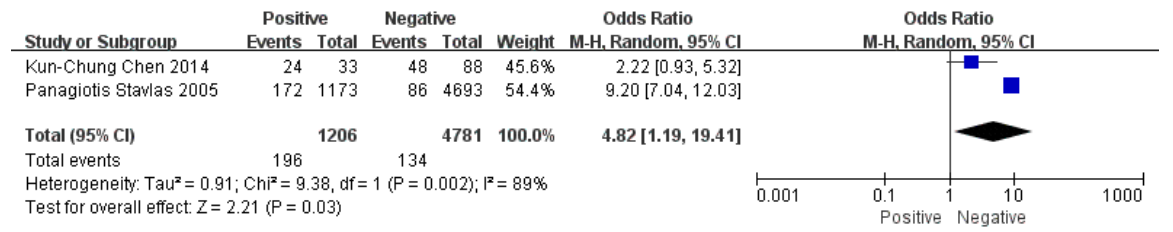
Figure 4. The forest plot of sex for flatfoot in children [7–9,11,13,14,16,18–20].